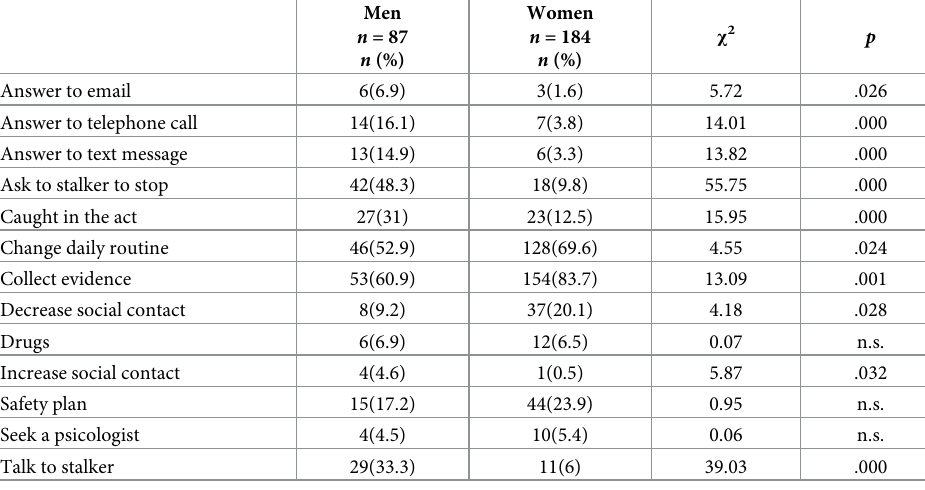
Table 4. Coping strategies in men and women reporting stalking case (N =